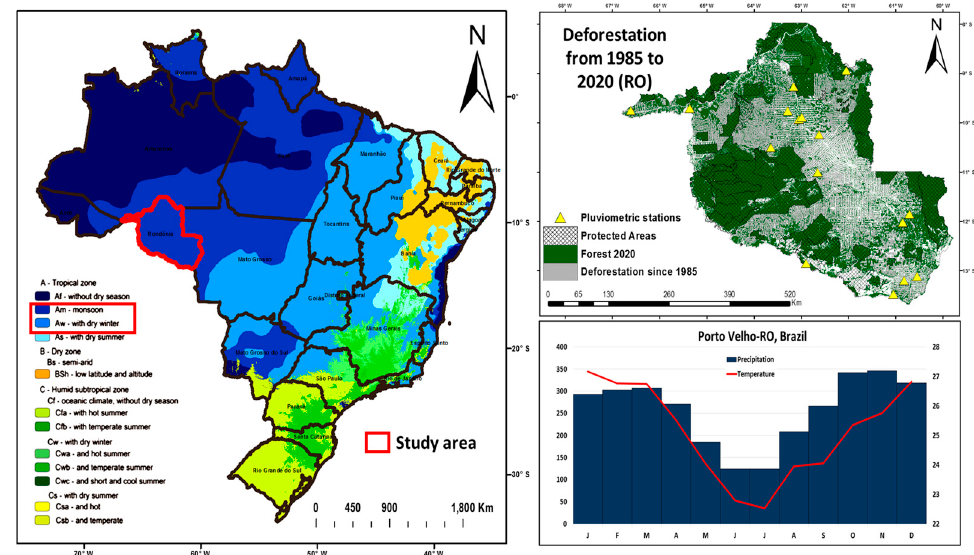
Figure 1. Study area presenting Köppen-Geiger climate classification; the location of rain gauges and classification of land use and occupation for the year 2020; and the loss of primary vegetation from 1985 to 2020; and the climatological normal (temperature and precipitation) from the capital of Porto Velho-RO.